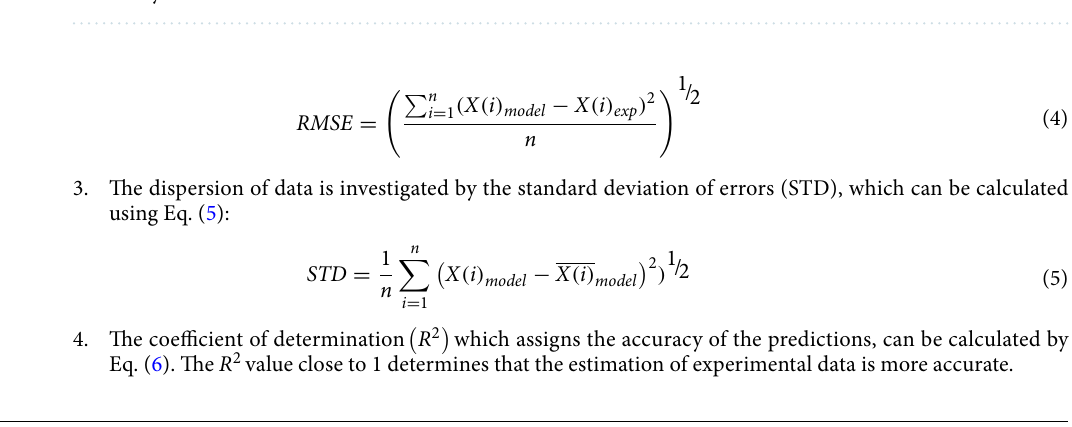
Figure 2. Feature selection and classification using different algorithm for predicting adsorption efficiency of arsenic by